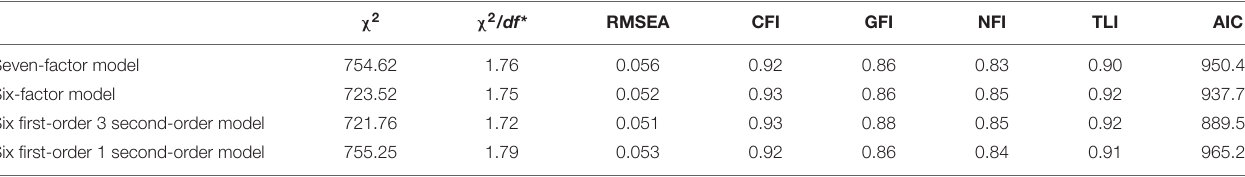
TABLE 2 | Model fit indices of different models of the SLEI-SC.